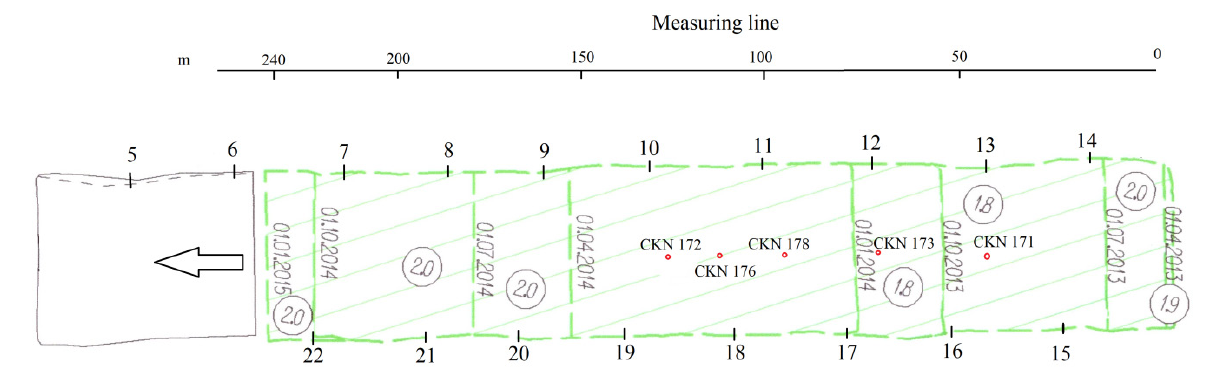
Figure 6: Location of the convergence points (not to